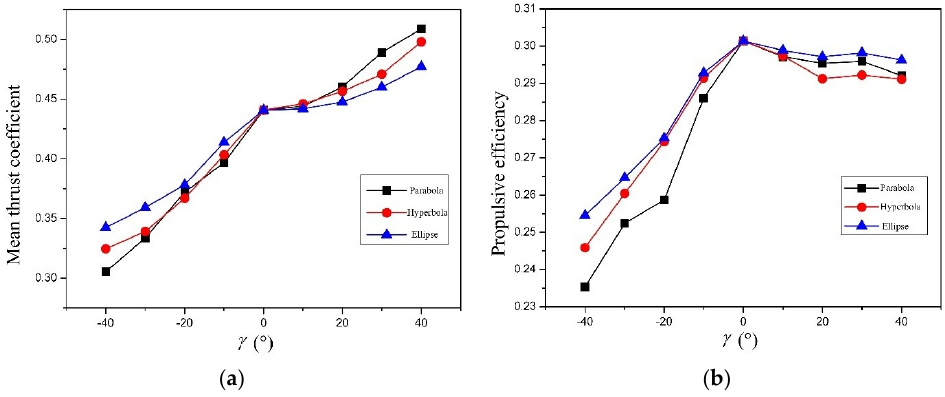
Figure 17. Performance curves versus phase angle: ( a ) mean thrust coefficient; ( b ) propulsive efficiency.